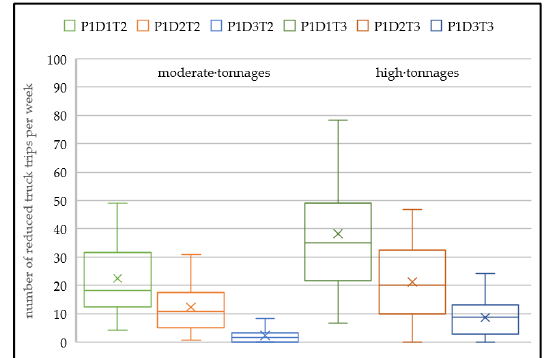
Figure 6. Reduced truck trips for two train pick-ups. P = train wagons pick-ups: P1 = one a day, P2 = two a day. T = tonnage of forest trucks equipped with crane: T1 = low, T2 = moderate, T3 = high. D = delivery time to train terminal: D1 = short, D2 = medium, D3 = long.